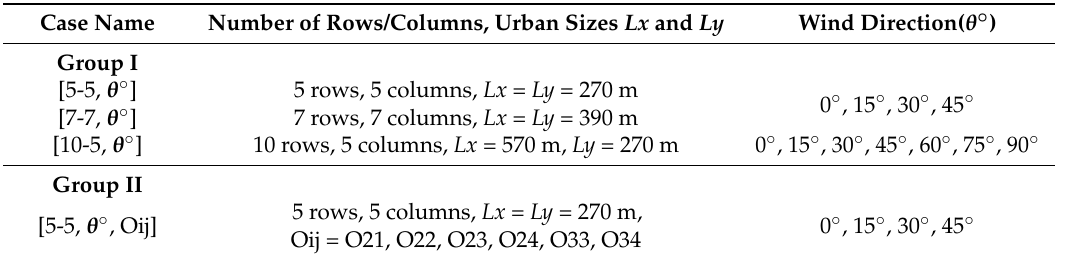
Table 1. Test cases investigated ( λ p = λ f = 0.25, H / W =